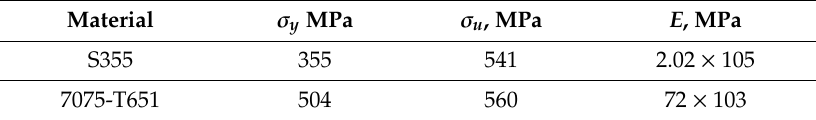
Table 4. Basic mechanical properties for the analysed